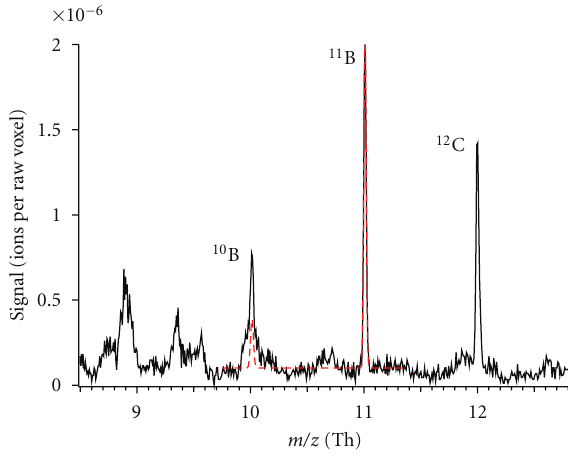
Figure 17: Part of the secondary ion mass spectrum from the multilayer zinc oxide/aluminium oxide ALD dataset shown in Figure 15. The red trace is a fit to boron with natural isotopic abundance, scaled and o ff set to the 11 B + peak. The roughness in the baseline, and the apparent broad peaks below 10Th are due to electrical interference from the extraction pulse (boron rich samples show the expected isotope ratio more clearly). There are no possible isobaric interferences for boron, so the identification is unambiguous. The fitted 10 B signal corresponds to about 350 detected ions in total.